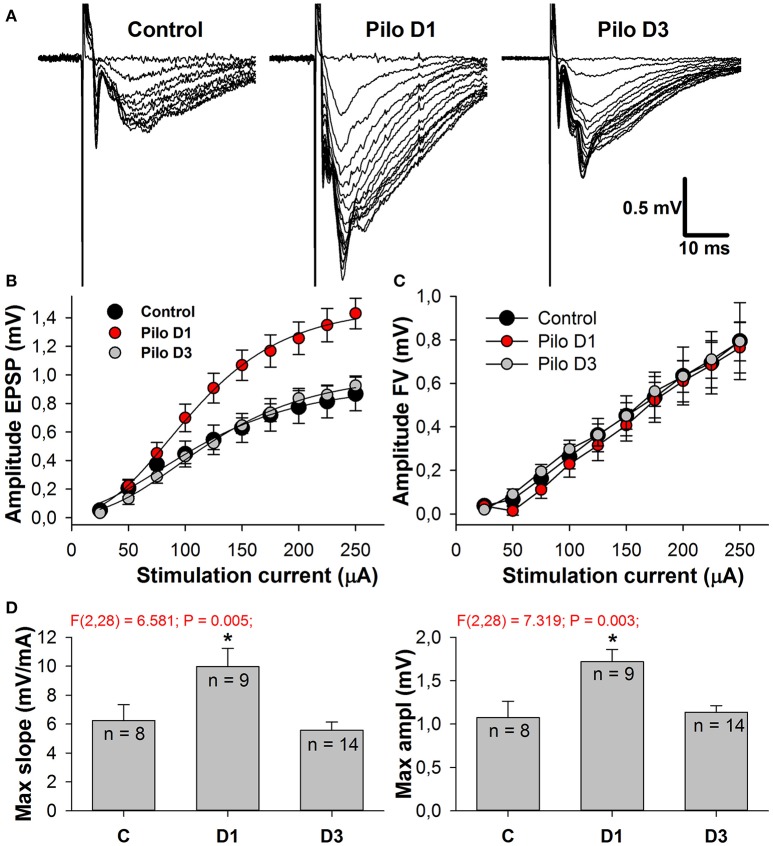
Amplitudes of fEPSPs are enhanced in PILO-rats. (A) Representative examples of fEPSPs recorded in the CA1 hippocampus of control and PILO-rats in 1 day (Pilo D1) and 3 days (Pilo D3) after administration of the drug. (B) and (C) Input-output (I/O) curves for the fEPSPs (B) and fiber volleys (C). (D) Bar graphs showing maximum slope of I/O curves for the fEPSPs (left) and predicted maximum amplitude of fEPSPs (right). An asterisk (*) indicates significant difference (p < 0.05) with the control group (Dunnett's post hoc test, multiple comparisons vs. control group).